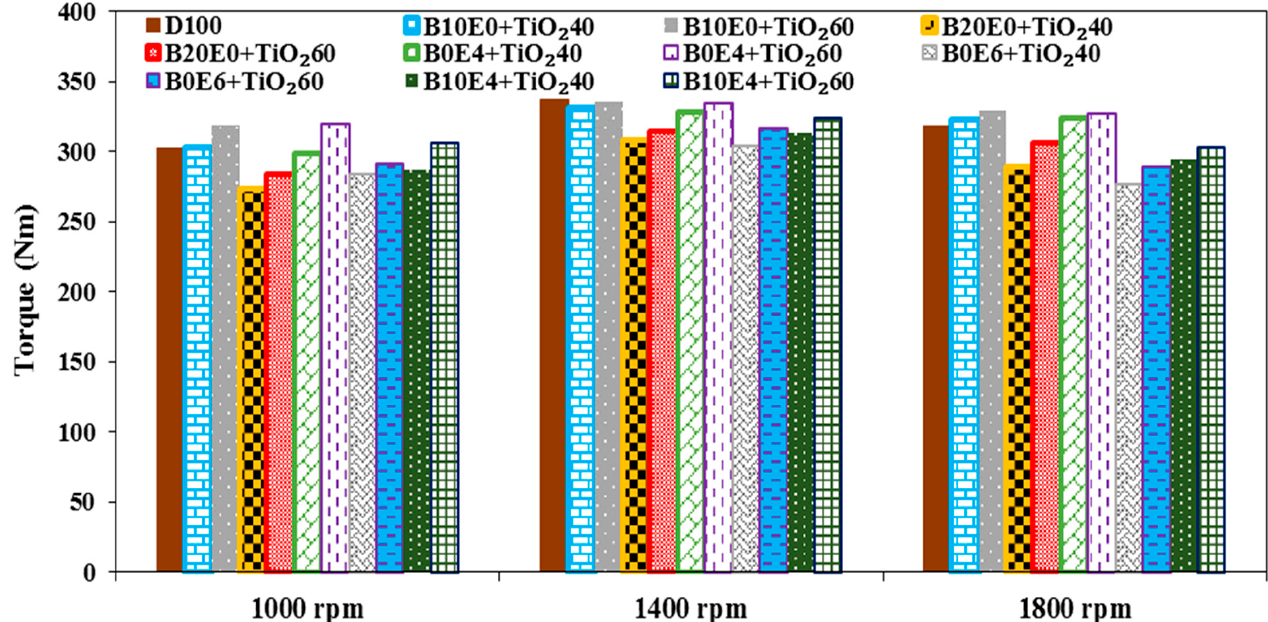
Figure 4. Variation of torque for diesel/ethanol/biodiesel blends at TiO 2 = 40, 60 ppm, and various engine speeds.